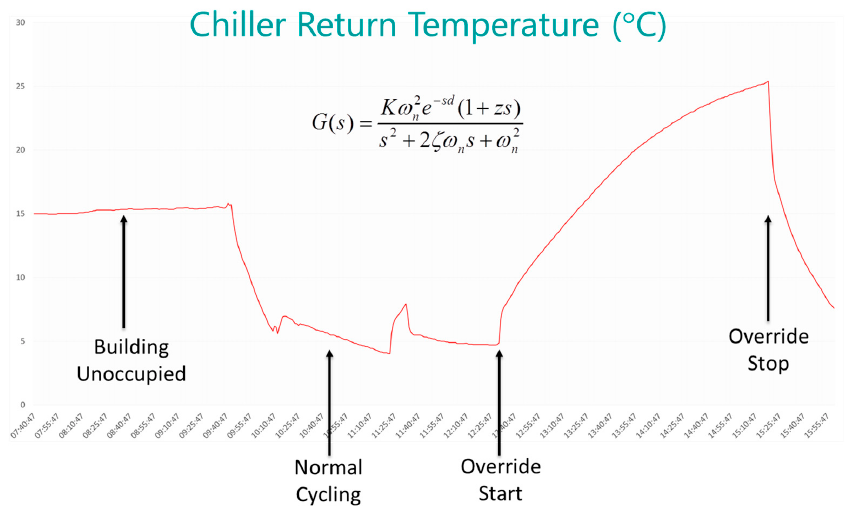
Figure 4. Measured chiller return temperature ( ◦ C).